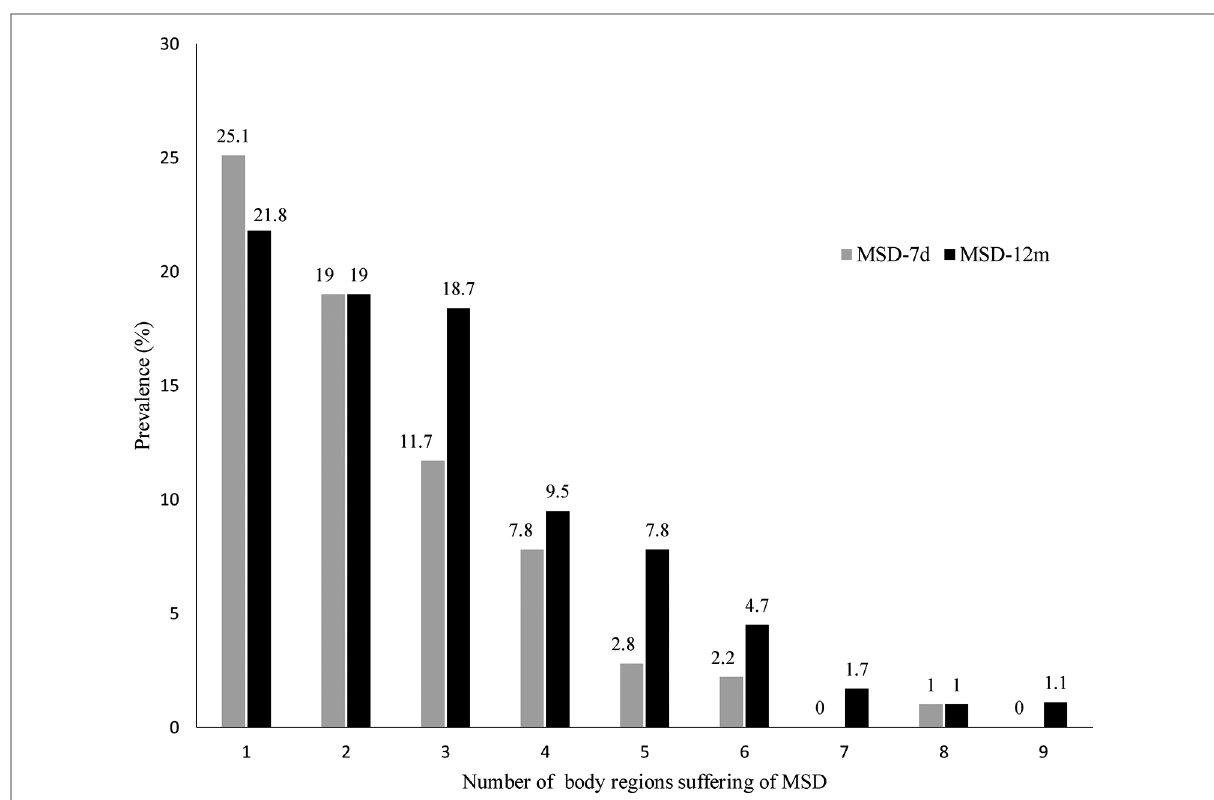
FIGURE 3 Prevalence of MSD according to the number of body regions affected. MSD-7d: MSD during the last 7 days; MSD-12m: MSDs during the last 12